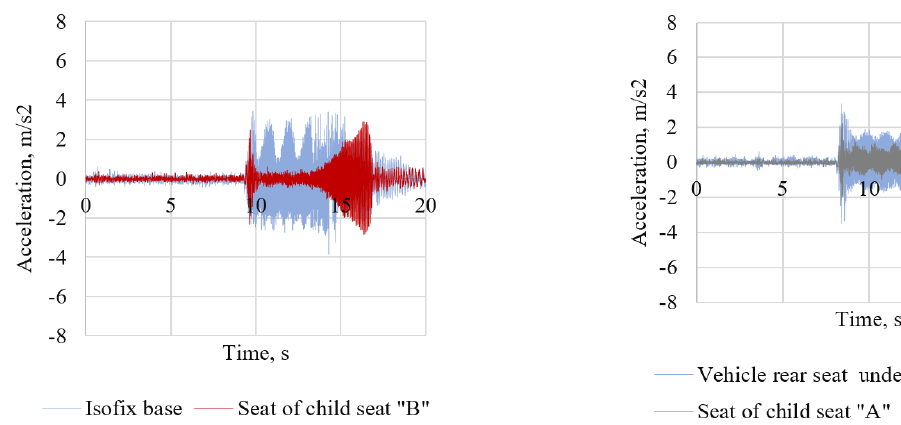
Figure 10: Vertical accelerations recorded on the seat A and ISOfix base (suspension in a dynamic position, the seat is loaded with a mass of 15 kg)